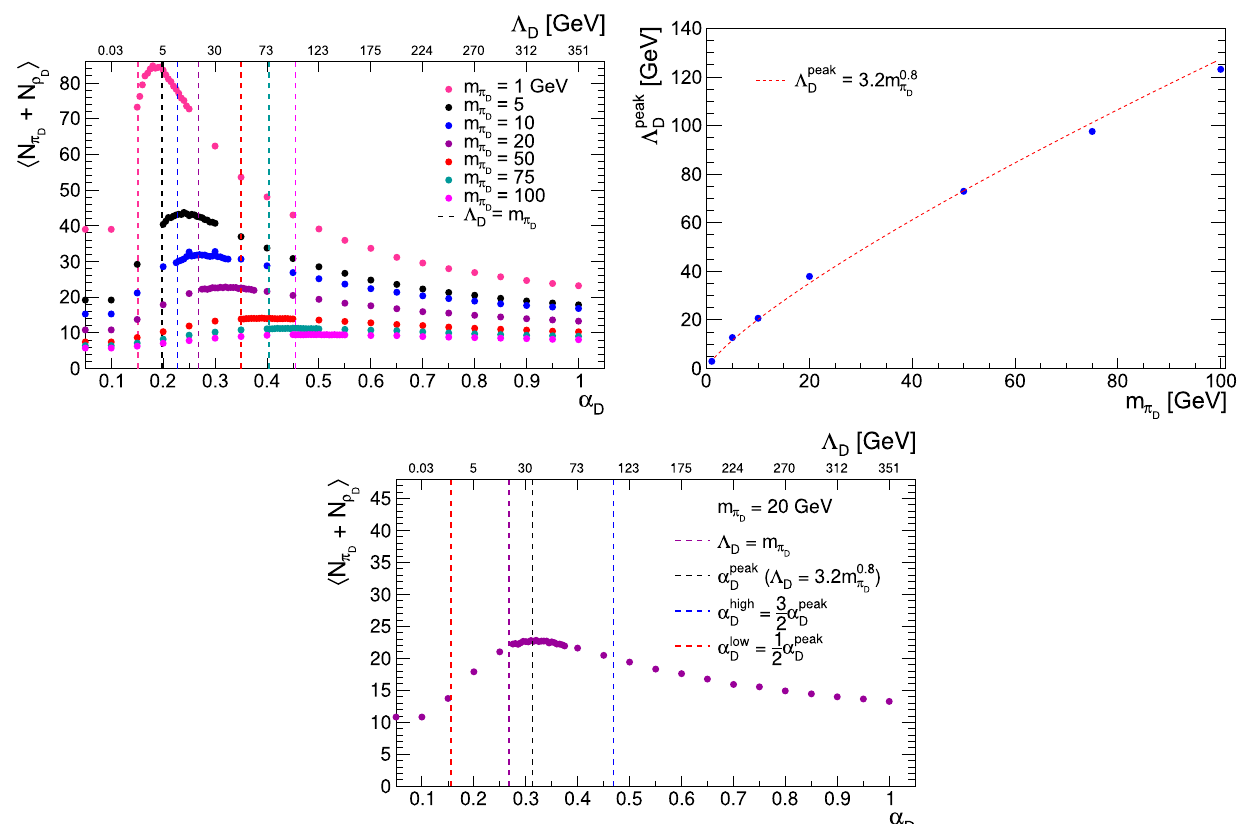
Fig. 6 Top left: the average number of dark hadrons, both stable and unstable, created per Z (cid:7) event by pythia 8.230 for different m π (cid:2) α D or D values. The behavior for accurate. Top right: For each m π